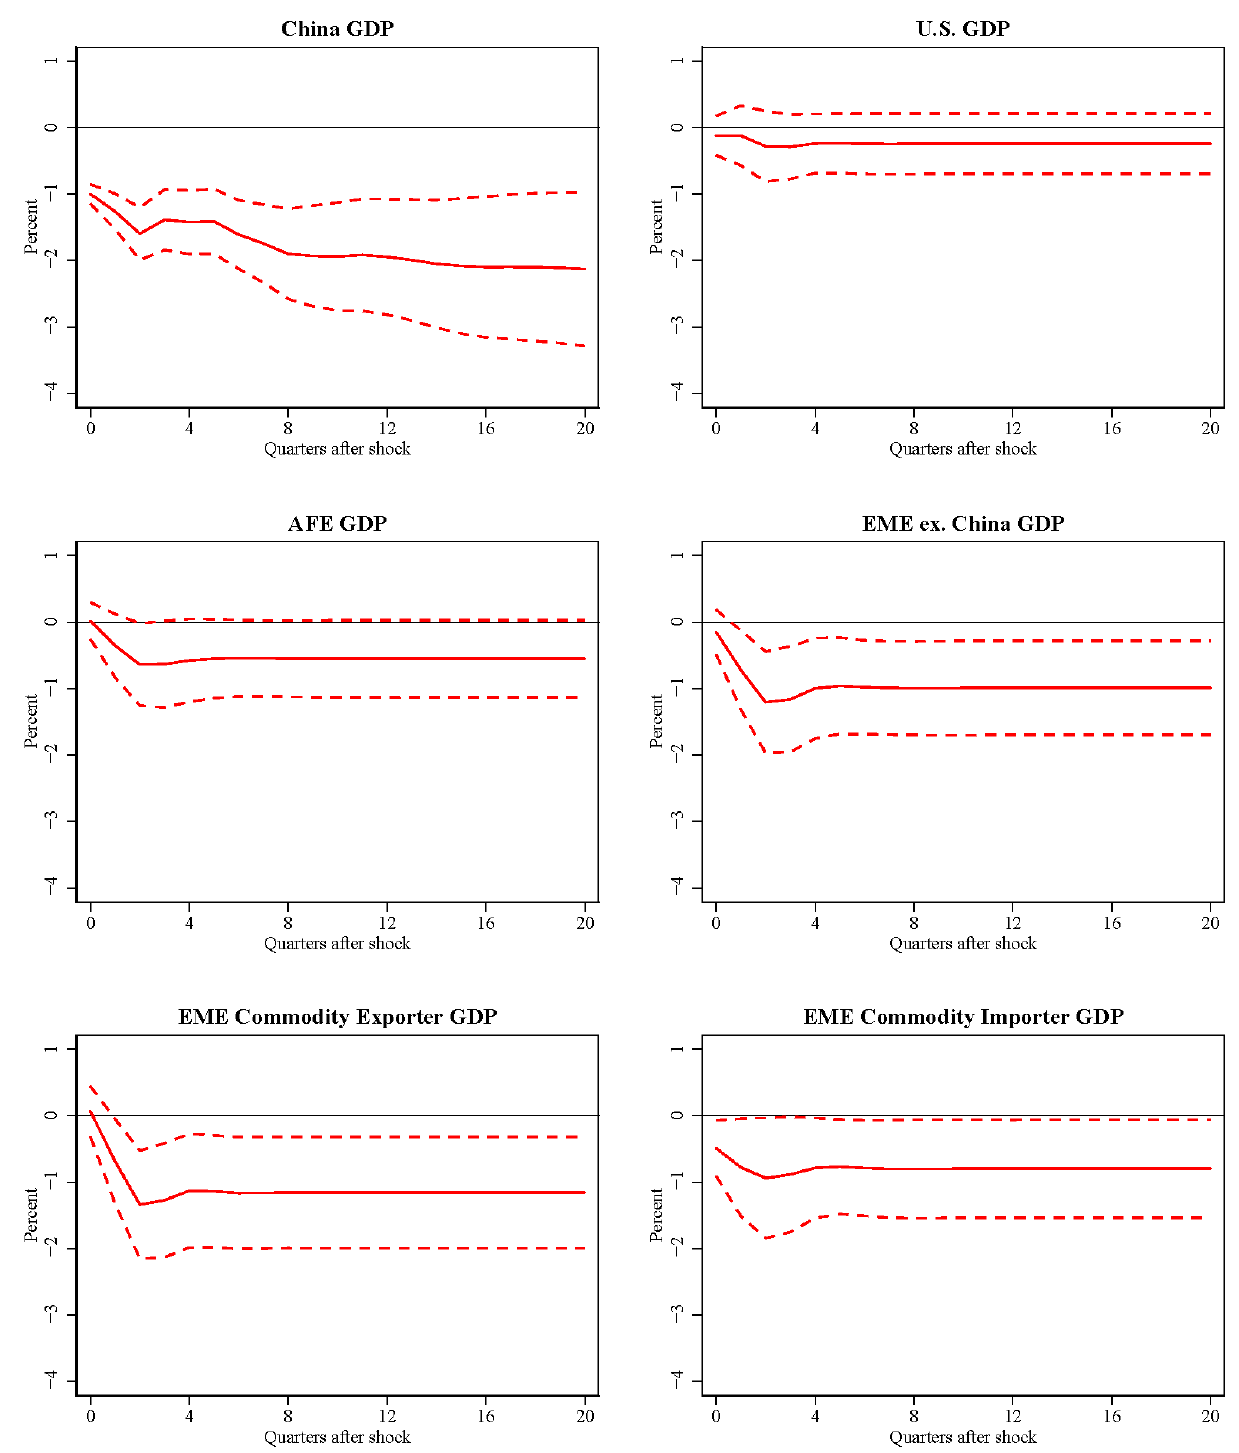
Figure 6. Activity responses to a negative unit domestic China GDP shock. Note: the dashed lines represent the upper and lower bounds of the 90% confidence interval around the impulse response estimate. Source: authors’ calculations using data from Haver Analytics and Bloomberg.